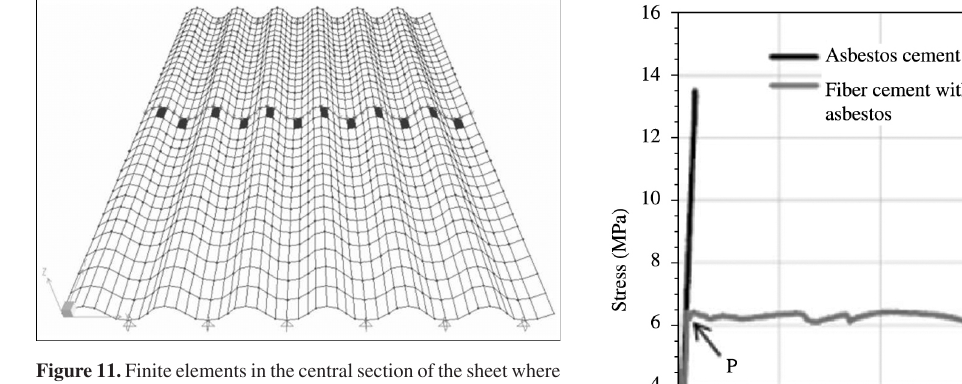
and σ were verified. max min